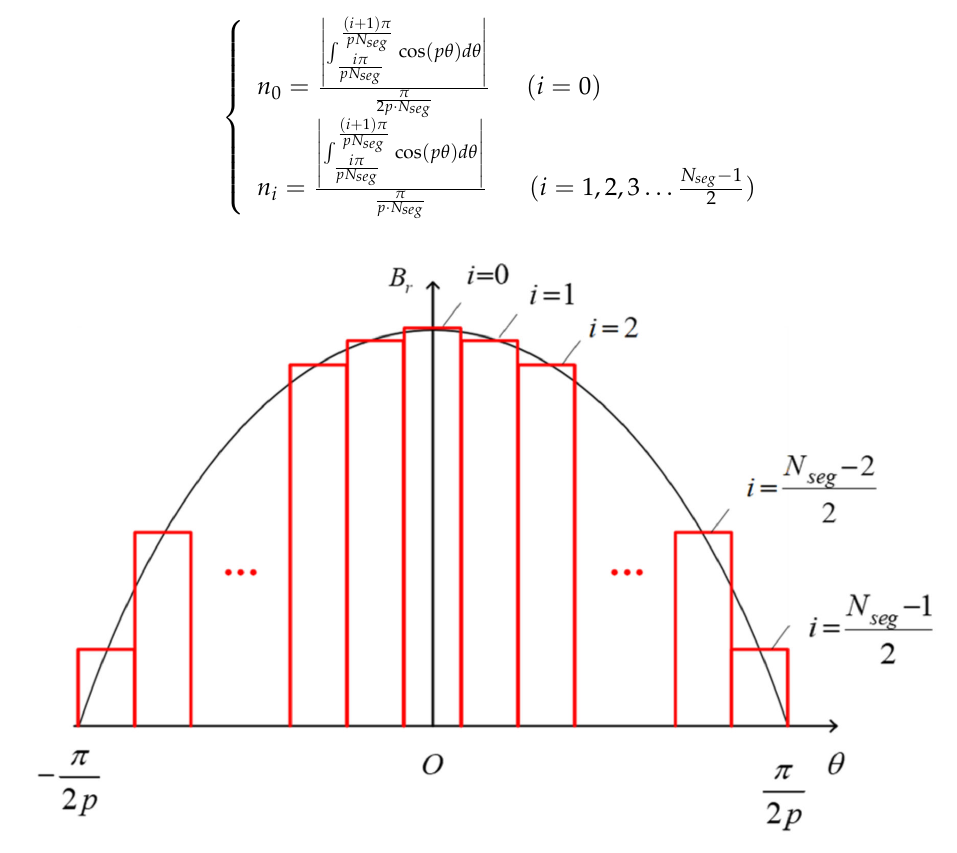
Figure 3. Stairs equivalent sinusoidal flux